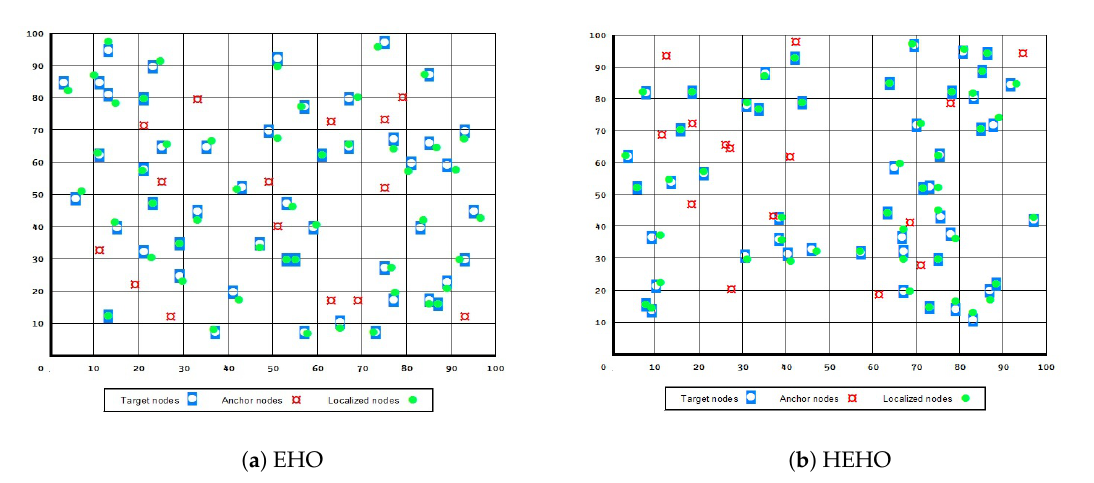
Figure 5. Node localization using original EHO and hybridized EHO.